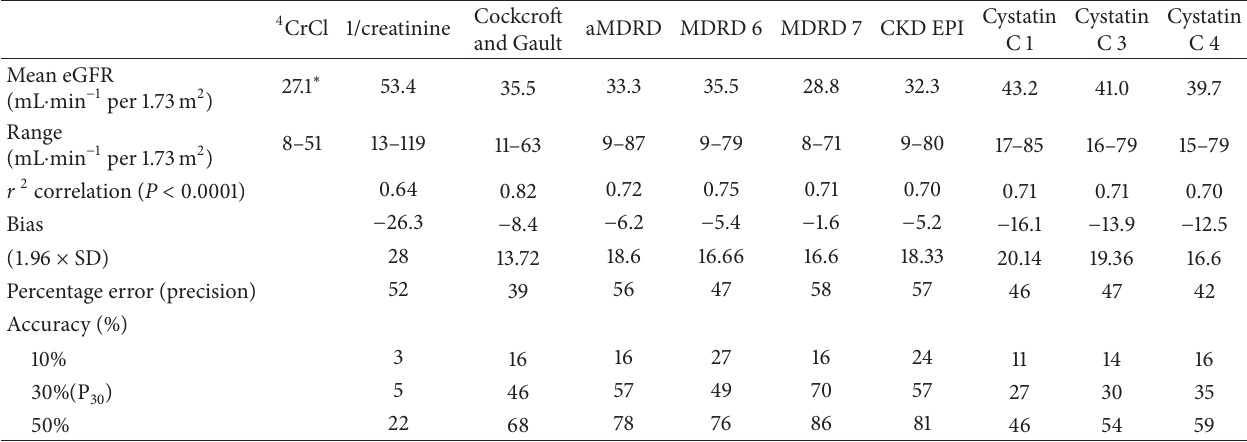
Table 3: A summary of the performance of eGFR equations in critically ill patients with AKI, whose 4 CrCl was less than 60mL ⋅ min − 1